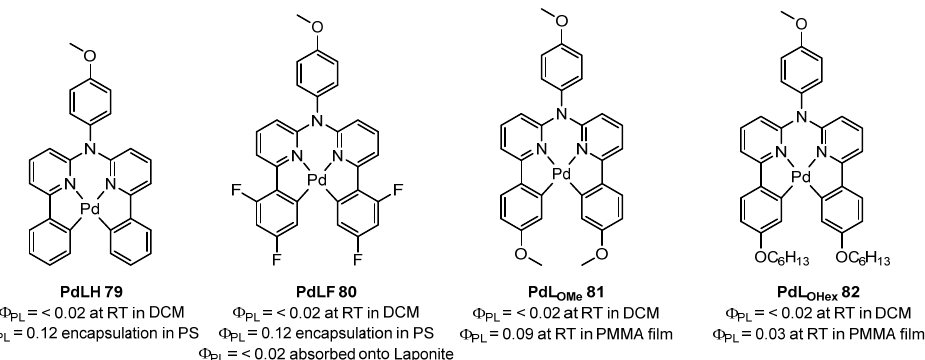
Figure 22. Pd(II) complexes 79 − 82 having a family of tetradentate ligands. Adapted from [88 − 90].